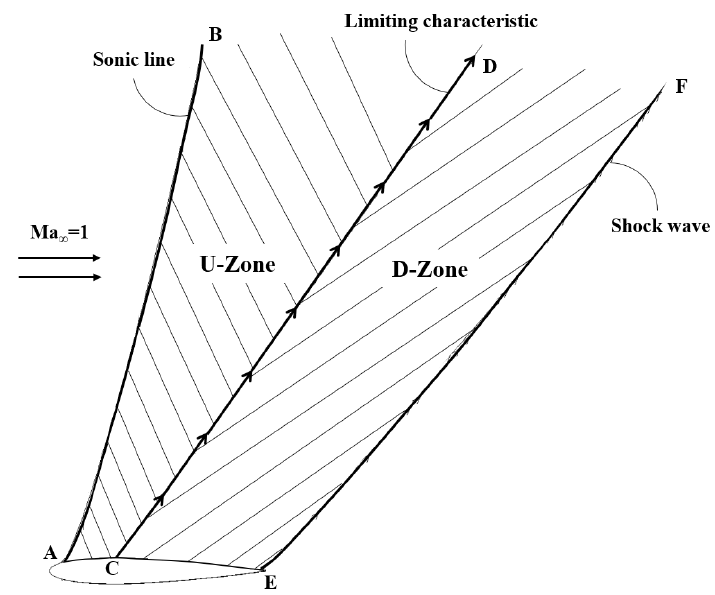
Figure 5. The U-Zone and